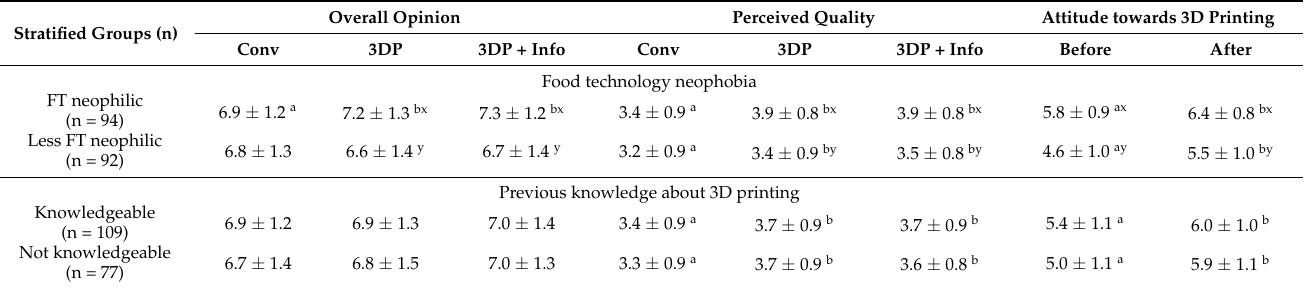
Table 4. Mean 1,2 overall opinion and perceived quality scores ± SD (N = 186) for all study products when presented as conventionally produced ( Conv ), 3D printed ( 3DP ), and 3D printed with product benefit information ( 3DP + Info ), and mean attitude towards 3D printing ± SD before 3DP and after 3DP + Info between and within stratified